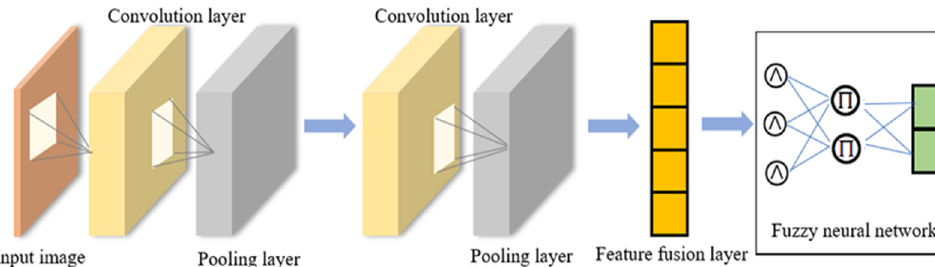
Figure 2. Architecture of the CFNN used in the FT-CFNN.